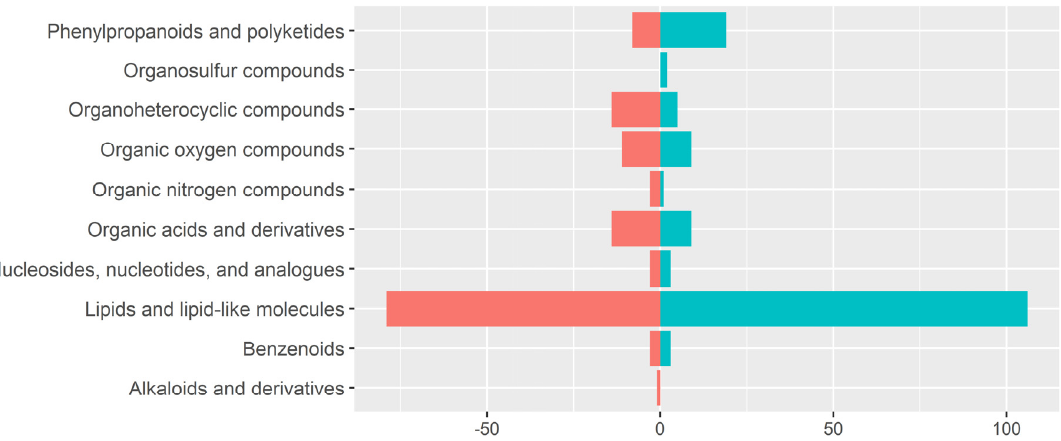
Figure 3. Super-class classification of chemical taxonomy of detectable metabolite features using REIMS. A total of 386 metabolites features were detected (210 in negative ion detection mode and 176 in positive ion detection mode) across all human milk samples. Using database searches and an accuracy threshold of <10 ppm, 293 features across both modalities were identified, Supplementary Figure S4a. Super-class level of chemical taxonomy using the Human Metabolome Database system is shown, with features detected negative ion detection mode shown in pink ( left ) and positive ion detection mode in blue ( right ). Class level identifications are shown in Supplementary Figure S4b.